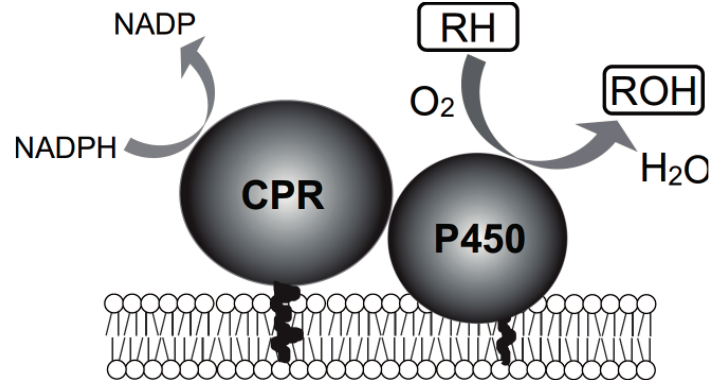
Figure 2. Cytochrome P450 (P450, CYP) monooxygenases. RH, substrate; and CPR, NADPH-P450